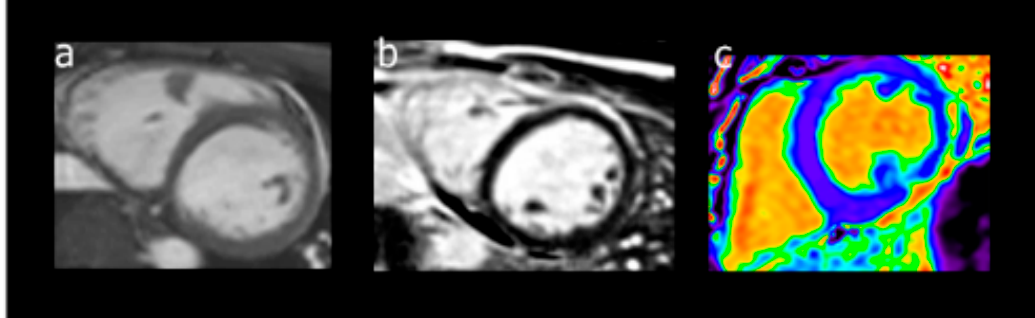
Figure 2. Pediatric cardiac MRI images, including panel a demonstrating a two-chamber short-axis cine image to evaluate cardiac size and function. Panel b shows a T2-weighted short-axis post-contract image used for the evaluation of late gadolinium enhancement and shows normal myocardium without any contrast present. Panel c shows a post-processing T1-weighted MOLLI sequence used to quantify myocardial extracellular volume (ECV).